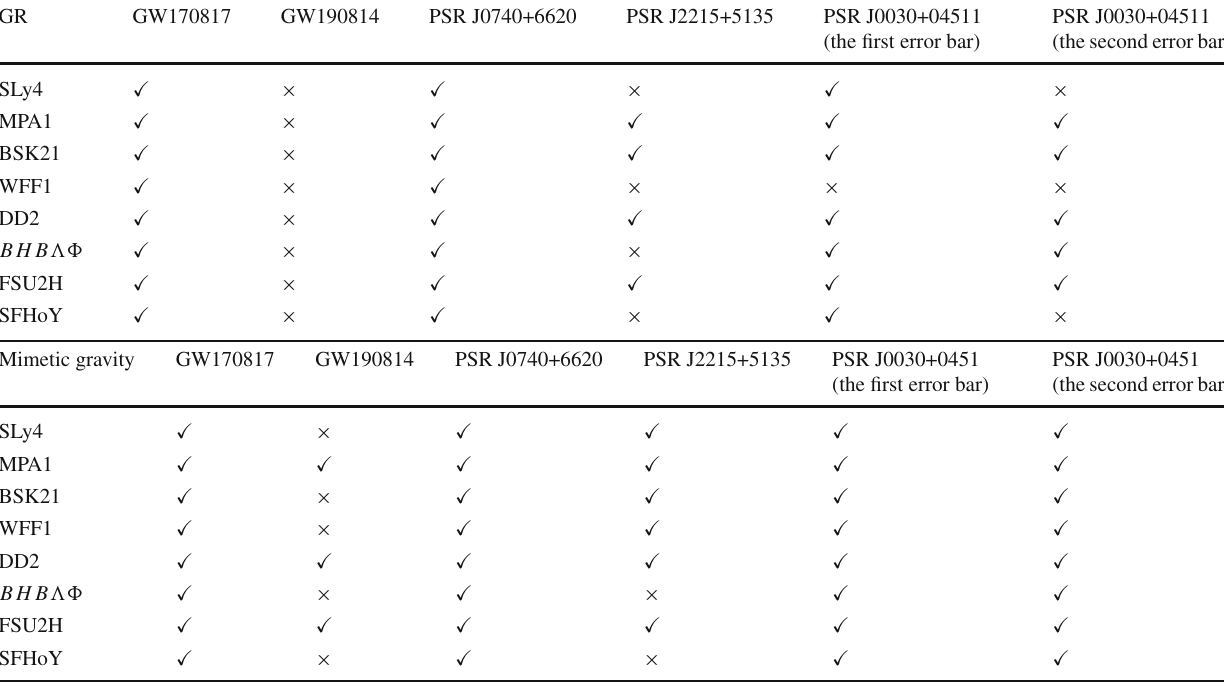
Table 5 The different observation data for the different EoSs in GR and mimetic gravity